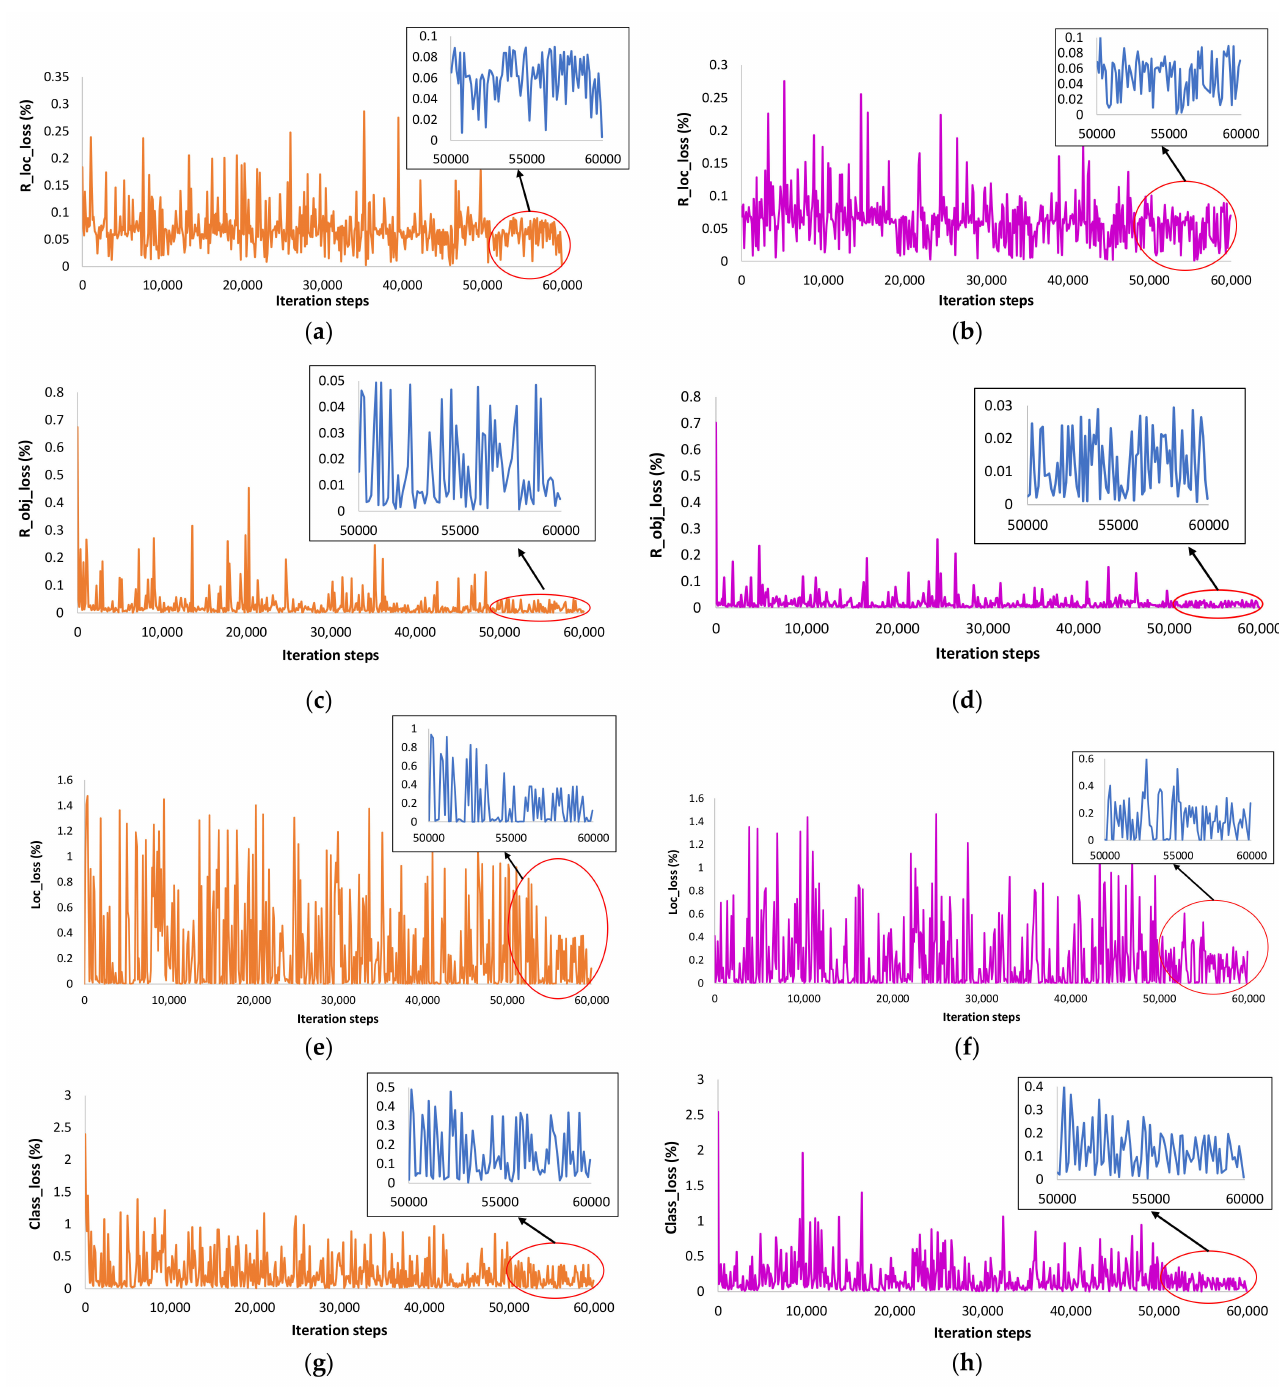
Figure 14. Training plots after adding different aspect ratios to the default: ( a ) presents the RPN localization loss with 1.5:1; ( b ) presents the RPN localization loss with 1:3 and 3:1; ( c ) presents the RPN objectness loss with 1.5:1; ( d ) presents the RPN objectness loss with 1:3 and 3:1; ( e ) presents the box classifier localization loss with 1.5:1; ( f ) presents the box classifier localization loss with 1:3 and 3:1; ( g ) presents the box classifier classification with 1.5:1; ( h ) presents the box classifier classification loss with 1:3 and